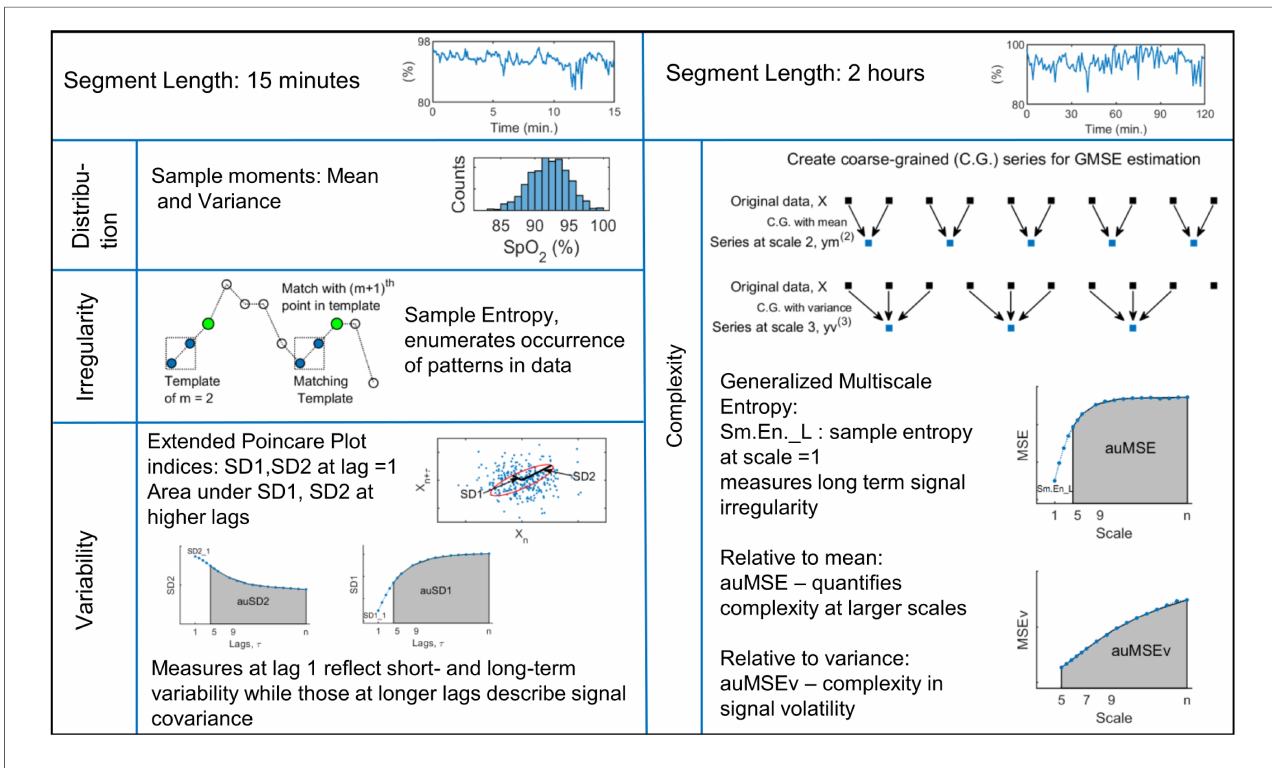
FIGURE 1 Schematic of the descriptive measures of SpO 2 data analyzed in this